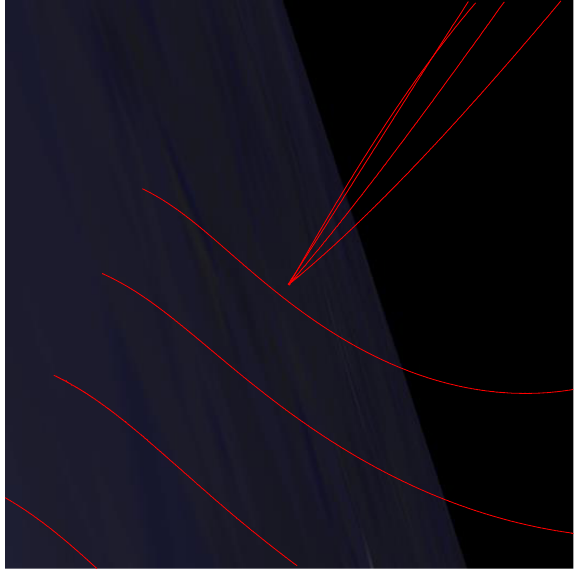
Table 5. The target initial states.